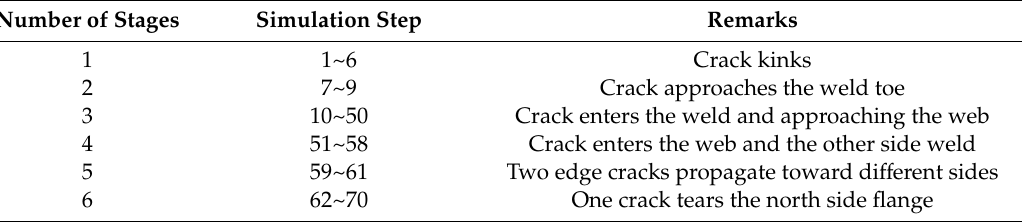
Figure 11. Schematic diagram of crack propagation evolution. Table 4. Stages of crack propagation.